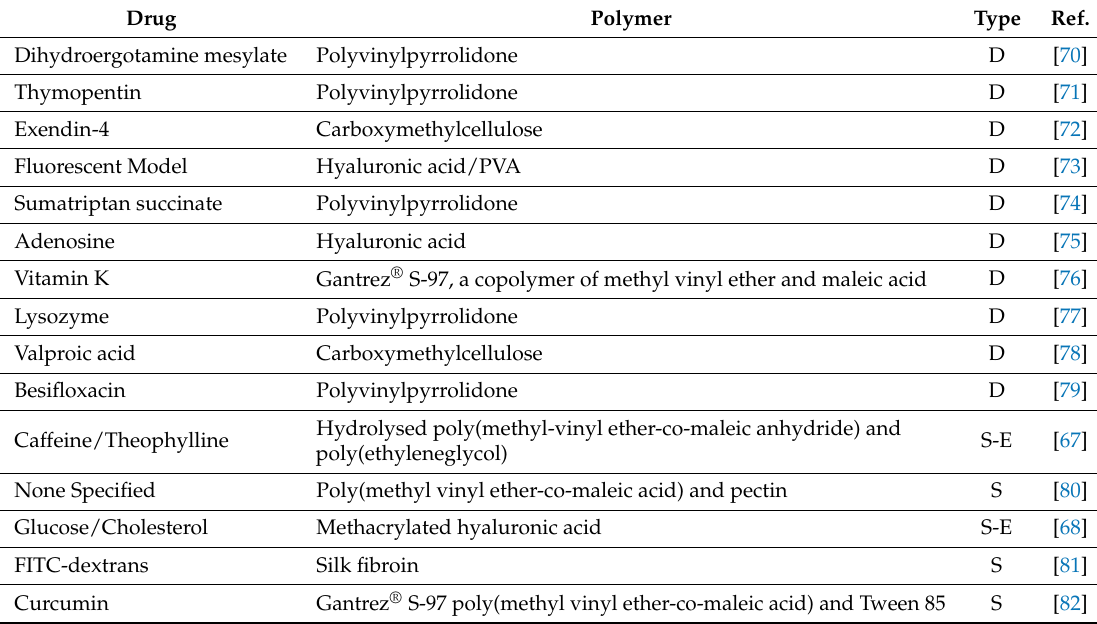
Table 1. Recent developments in dissolvable/swellable microneedle systems. Drug Polymer